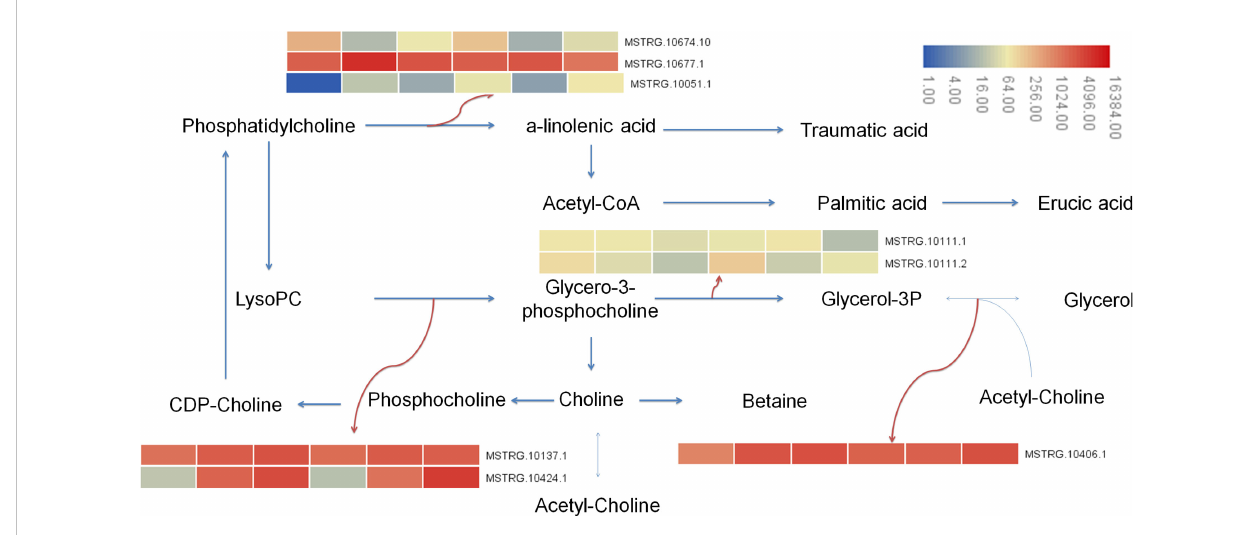
FIGURE 10 Lipid metabolism pathway in buckwheat leaves under Cd stress. The sample number in the order from left to right in the heat map: DK9-0, DK19-1, DK19-2, K33-0, K33-1 and